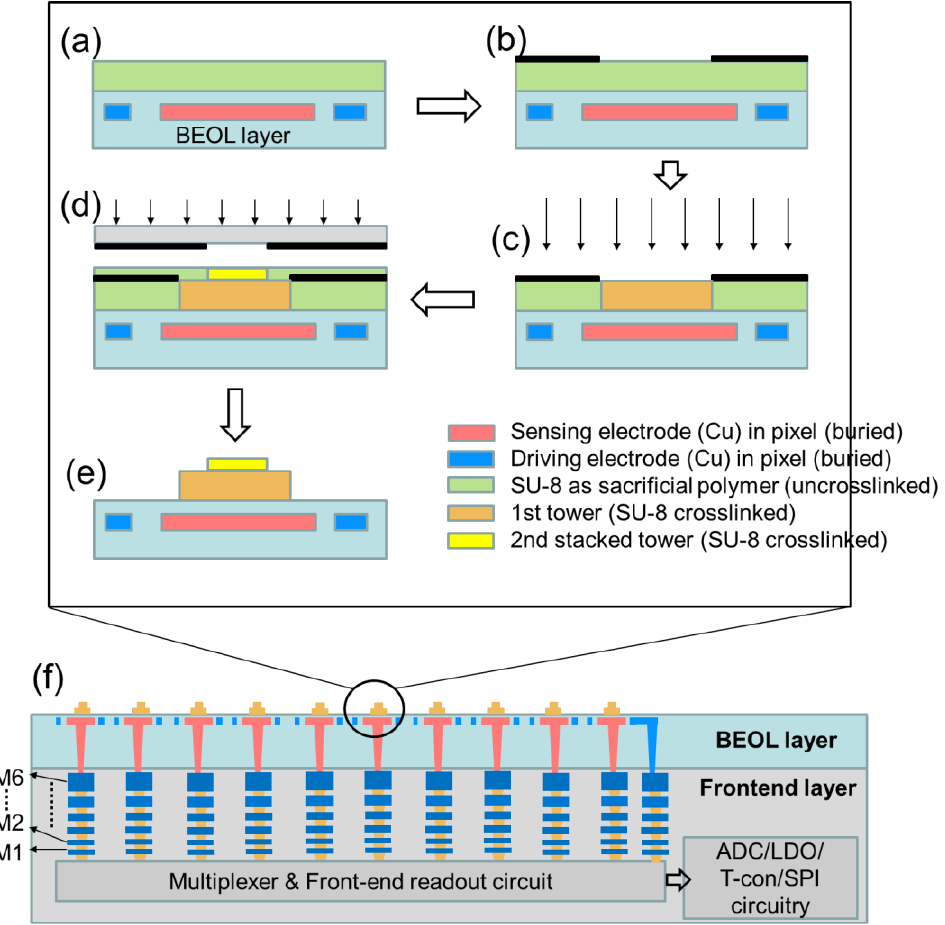
Figure 4. The process flow of proposed MEMS-based double stacked tower biosensor array. ( a ) spin coating of SU-8 as a sacrificial layer, ( b ) deposition and patterning an UV blocking layer, ( c ) blanket exposure to UV, ( d ) spin coating SU-8 and then exposure to UC, ( e ) development and etching the UV blocking layer. ( f ) cross view of integration of MEMS biosensor and front-end readout circuit and signal processing circuit.